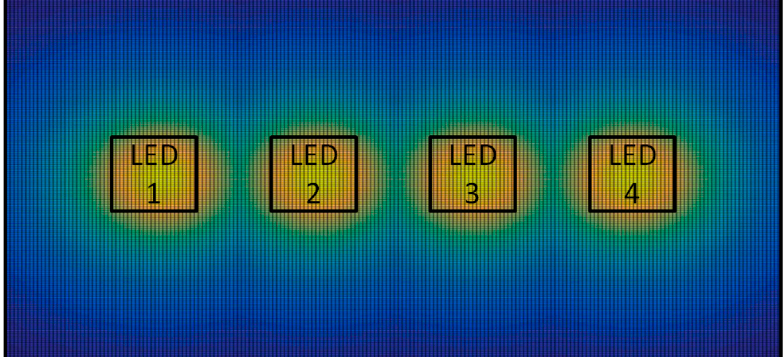
Figure 3. Ceiling overview of the light-emitting diode (LED) pattern.